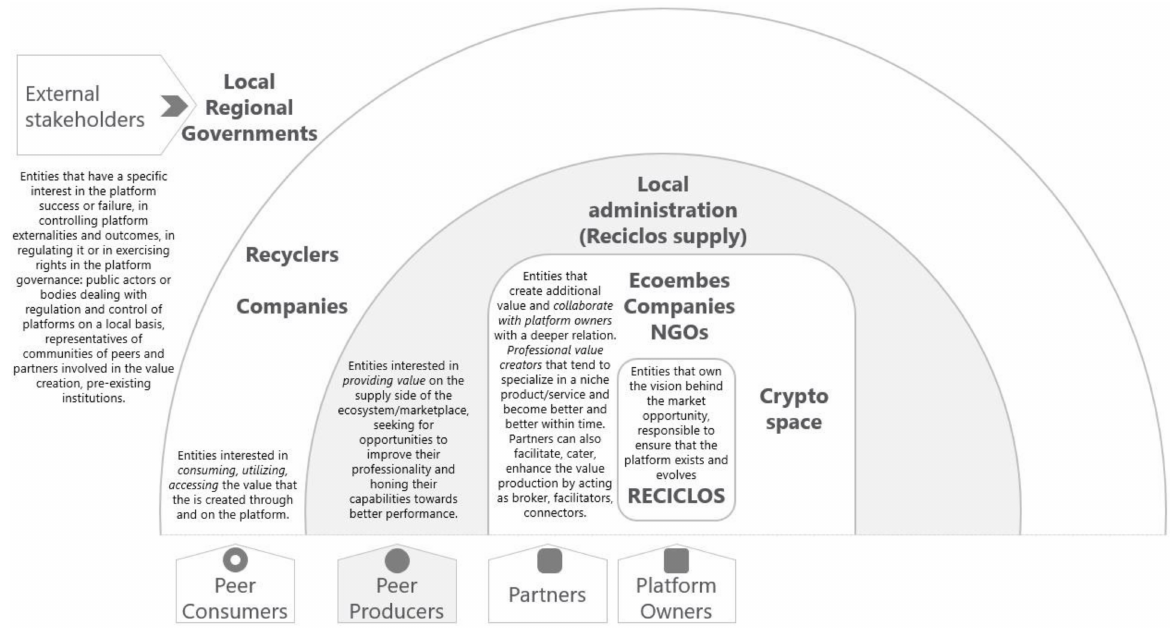
Figure 5. RECICLOS—main stakeholders. (Note: own elaboration based on [41]). Vision—To integrate lotteries and virtual currencies to reward recycling results in